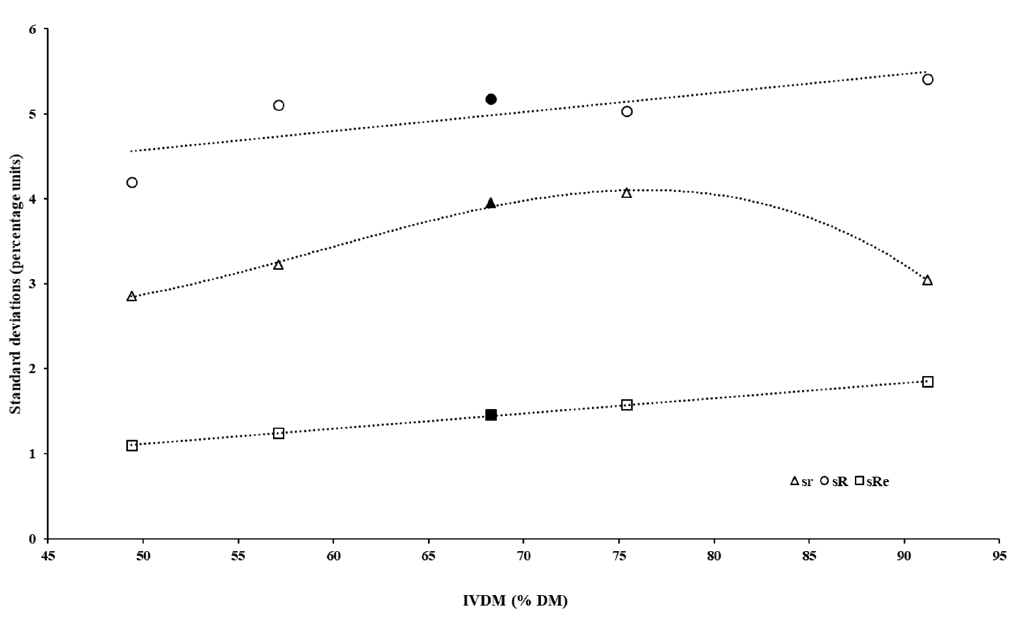
Figure 7. Descriptive pattern of the standard deviations of repeatability (sr), reproducibility (sR), and expected reproducibility (sRe) according to average values of in vitro dry matter digestibility (the central black data point corresponds to the mean digestibility for the overall dataset).